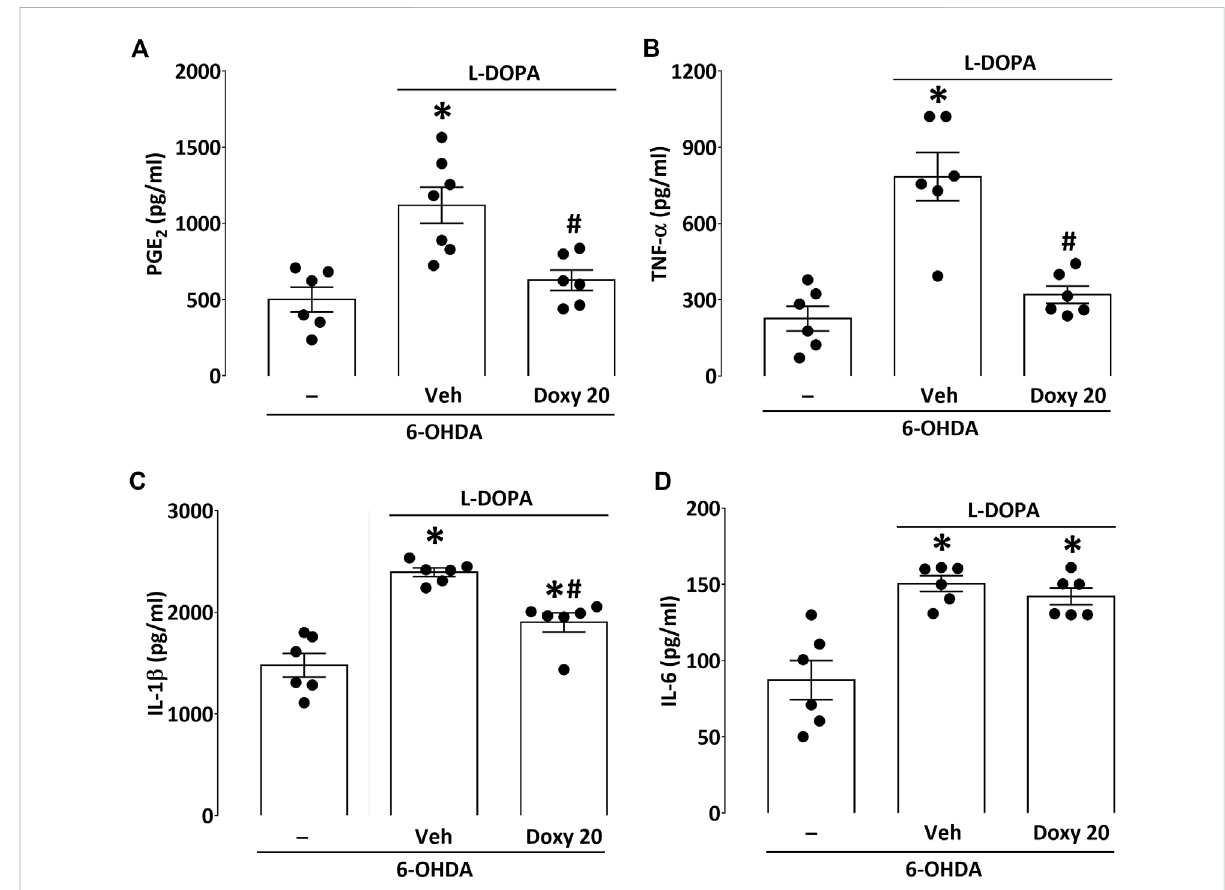
Effect of Doxy co-treatment on the production of PGE 2 and pro-in fl ammatory cytokines in mice with partial lesions. (A) L -DOPA treatment